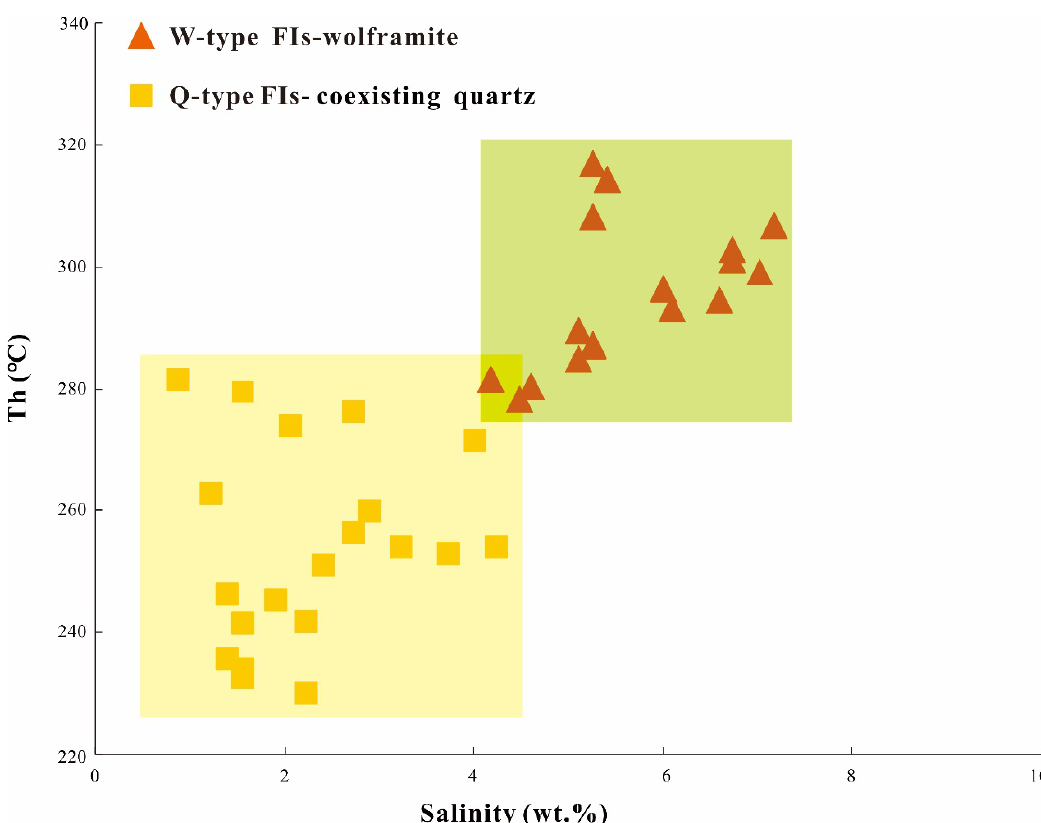
Figure 16. Homogenization temperature vs. salinity plot of inclusions in wolframite and its coexisting quartz.